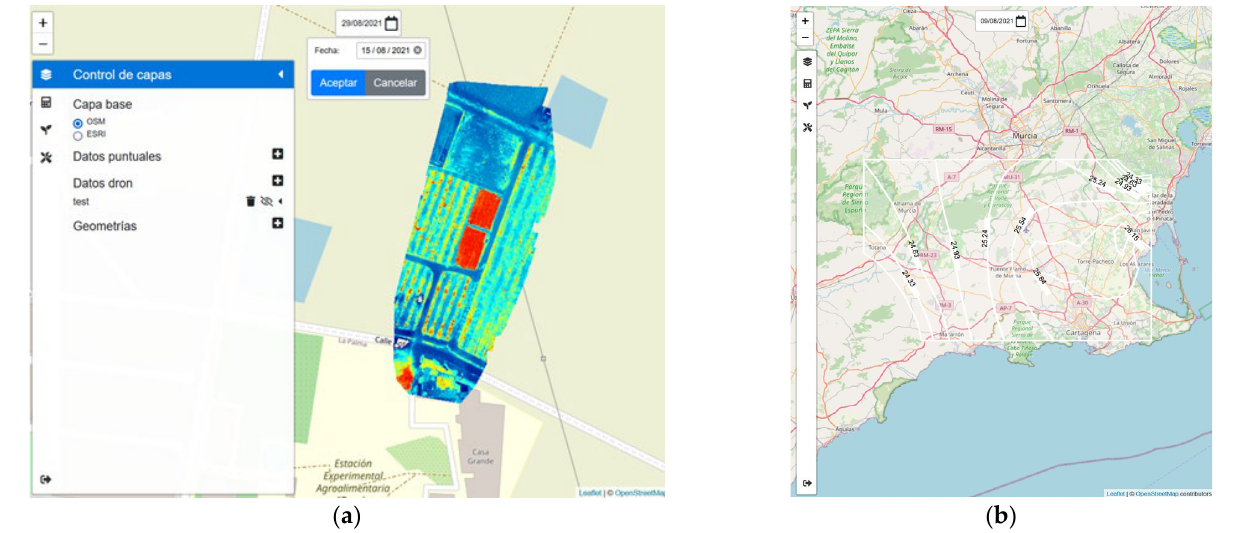
Figure 5. Detail of several functionalities found in the GIS tool. ( a ) Representation of a map with an information layer that contains data calculated from images collected by a drone in a specific interval of time. ( b ) Isoline map that cartographically shows temperature data.